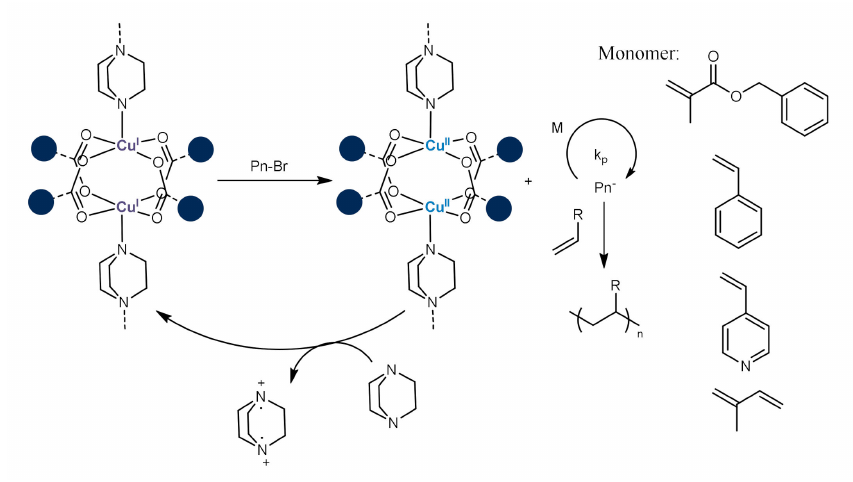
Figure 6. The structures of Cu-based MOF and the mechanism for ARGET ATRP.